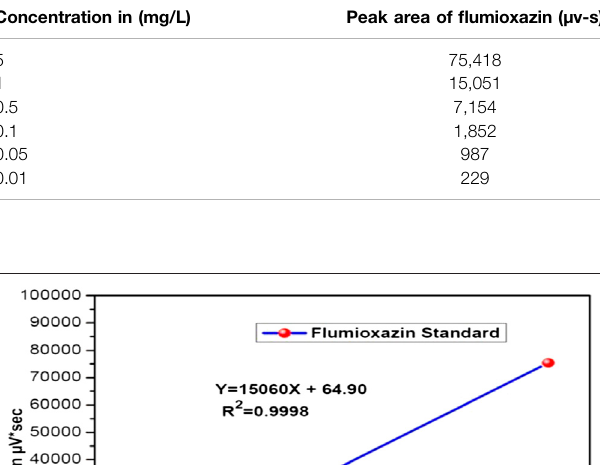
TABLE 4 | Dissipation data for photocatalytic decontamination of fl umioxazin in water under direct sunlight.